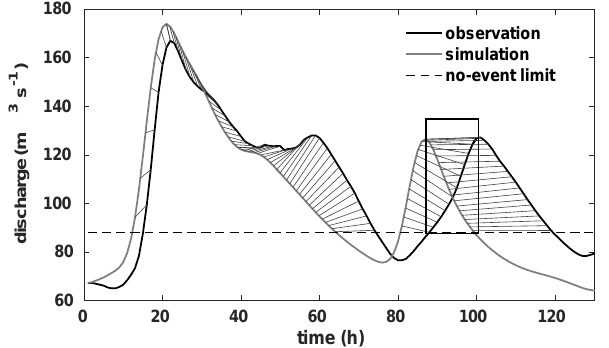
Figure 1. Time series of observed (black) and simulated (grey) dis- charge during a hydrological event. The horizontal line represents a user-specific threshold which differentiates between event and non- event periods. The light grey lines represent the Series Distance con- nectors linking hydrologically comparable points in the two time series. Time and magnitude distances are calculated between these points. The black rectangle highlights time steps where a part of the recession of the simulation overlaps with a rising part of the obser- vation (figure from Ehret and Zehe,